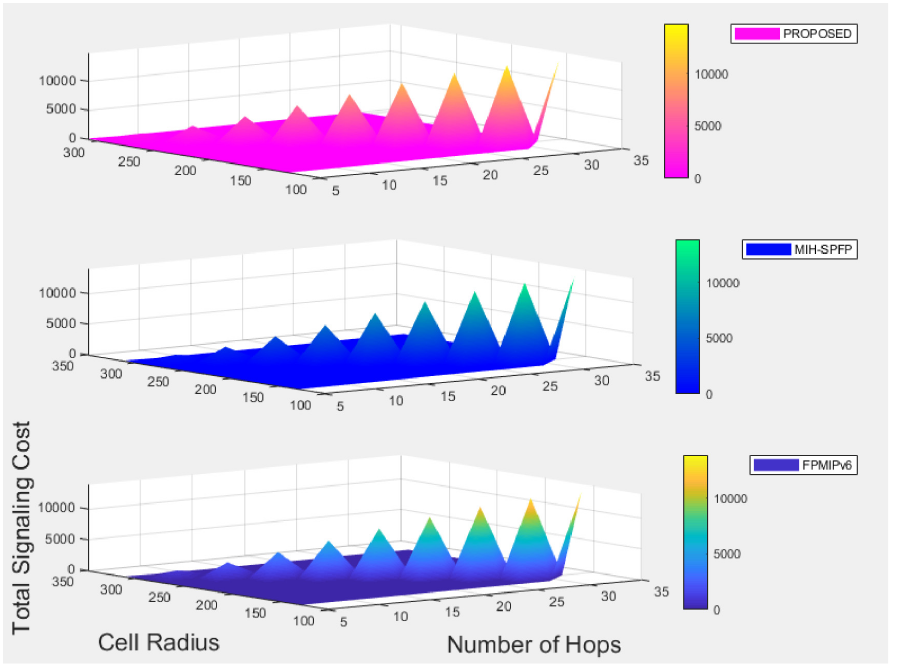
Fig 8. Wireless and wired total signaling cost comparison.